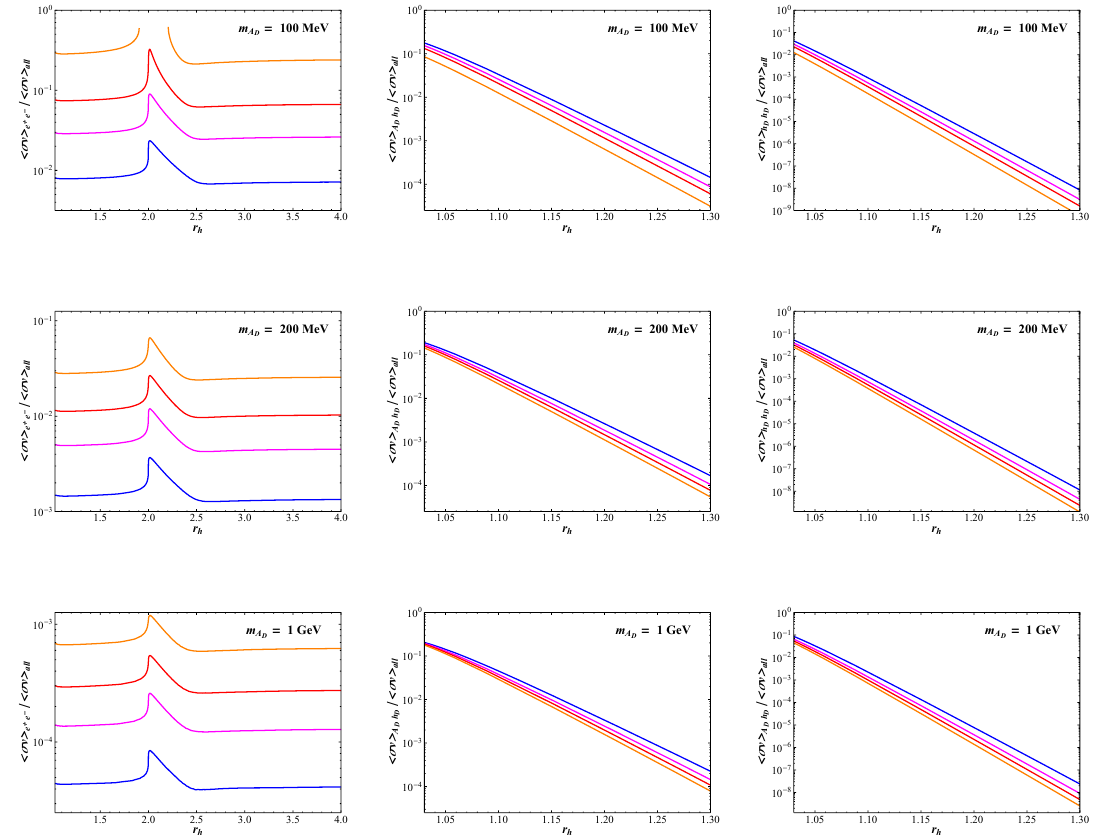
Figure 9. The values of the thermally averaged annihilation cross sections σv σv (Center), and (Right) as a function of r h , with r φ adjusted to reproduce h i A D h D h i h D h D the observed DM relic density. Each chart assumes b = 1 and g D = 0 . 3 (Blue), 0 . 5 (Magenta), g D = 0 . 7 (Red), and g D = 1 (Orange). As before, the discontinuity in the g D = 1 line in the m A = 100 MeV chart emerges because, for this dark photon mass and dark coupling, the observed D DM relic abundance cannot be recreated with any 1 < r φ < 2 when 1 . 9 . r h . 2 . 2